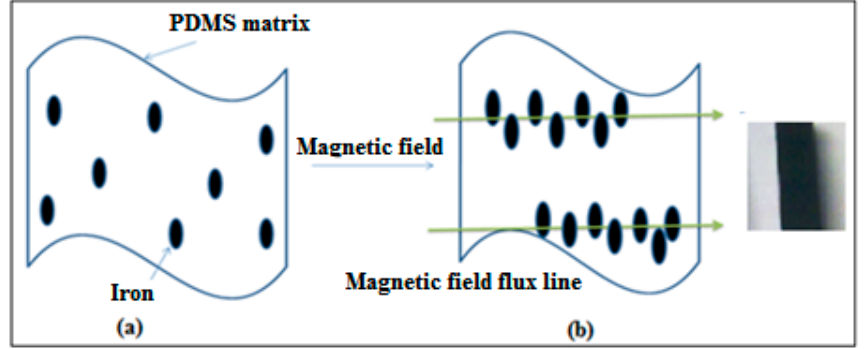
Figure 4. Illustrated schematics and photo of Fe-PDMS composite.